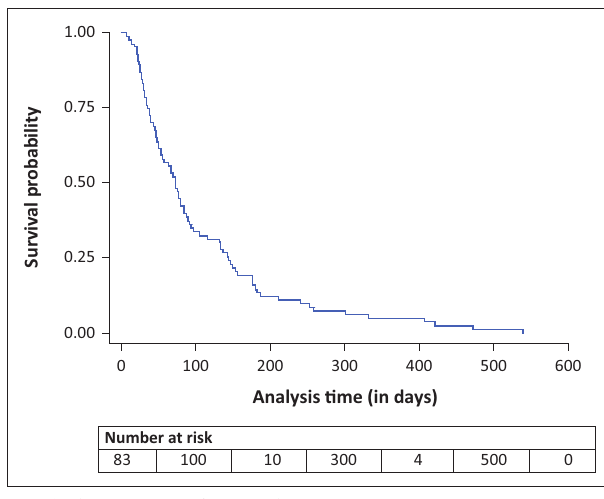
DPFS, dysphagia progression-free survival. FIGURE 4: Kaplan-Meier survival estimate for DPFS in all patients who received palliative